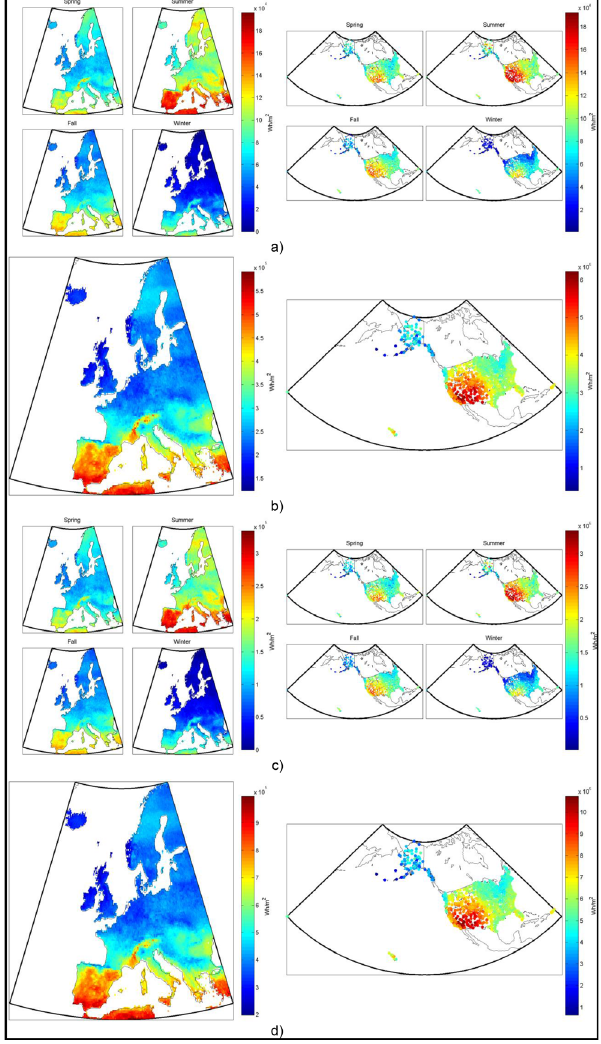
Figure 5. Hybrid CPV/T system’s (a, b) electricity and (c, d) heat production at 373 K, from one square meter of collector, both (a, c) seasonally and (b, d) annually in (left) Europe and (right) the